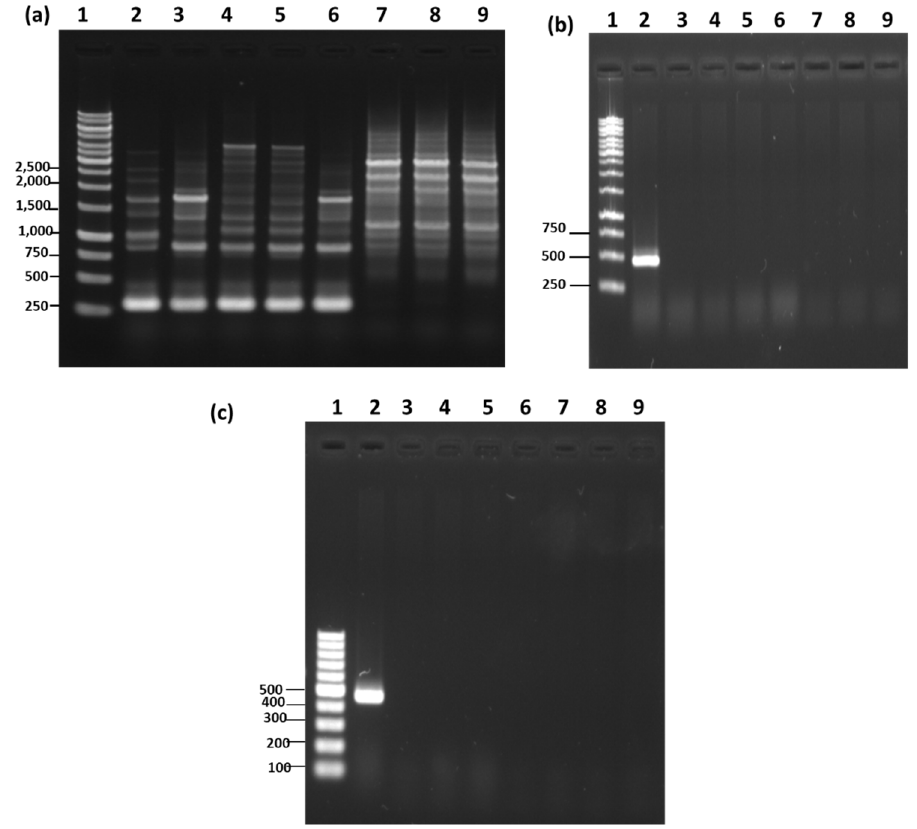
Figure 3. ( a ) RAPD-PCR for various reference strains of Bacillus subtilis . Lane 1: 1 kb size ladder (unit: